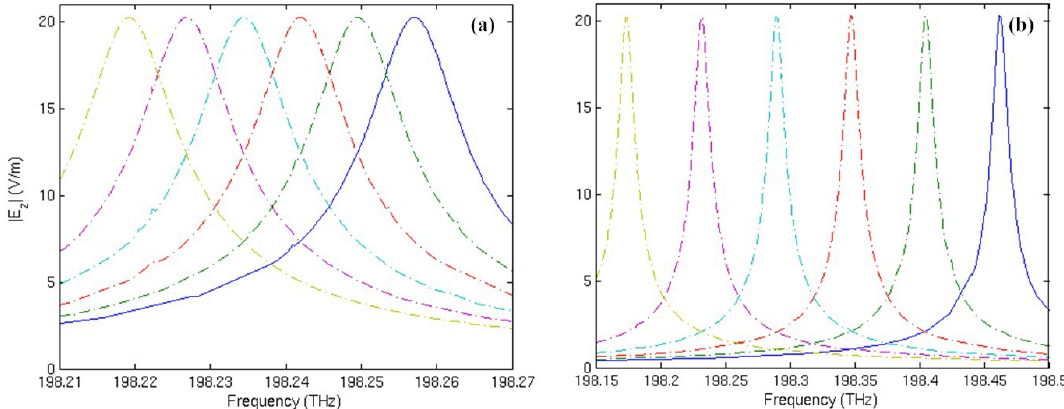
Figure 6. Resonant frequency spectrum of mode 27 with respect to the change of core medium permittivity ε . From left to right, the curves correspond to s 1.08 and 1.1, respectively. (a) The traditional microring sensor. (b) The metamaterial sensor.